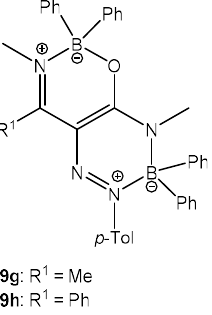
Figure 5. Oxazaborine–triazaborines 9g and 9h .